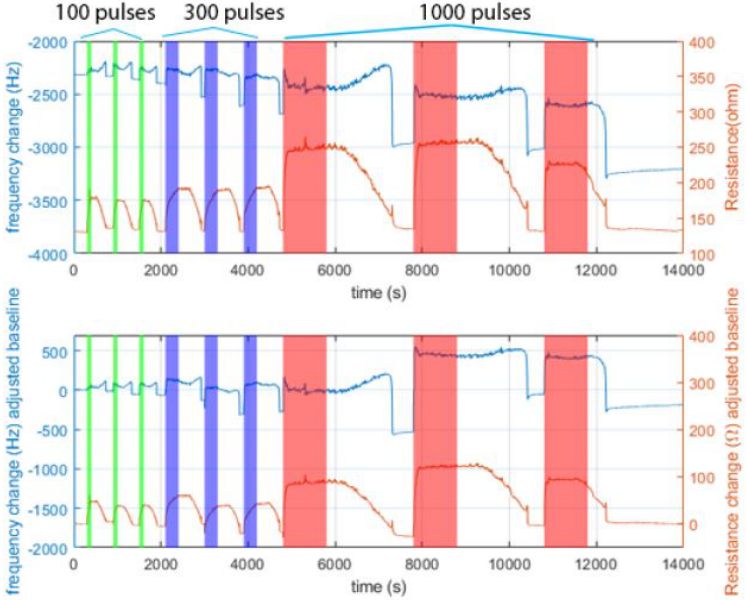
Figure 29. Response of QCM coated with PEG2000 when exposed to water. The color bar means period of exposure. Blue line: frequency shift. Orange line: resistance change. Top figure shows the raw data, and bottom figure shows the data after adjusting baseline before each deposition. Reprinted from [76] under the Creative Commons CC BY 4.0